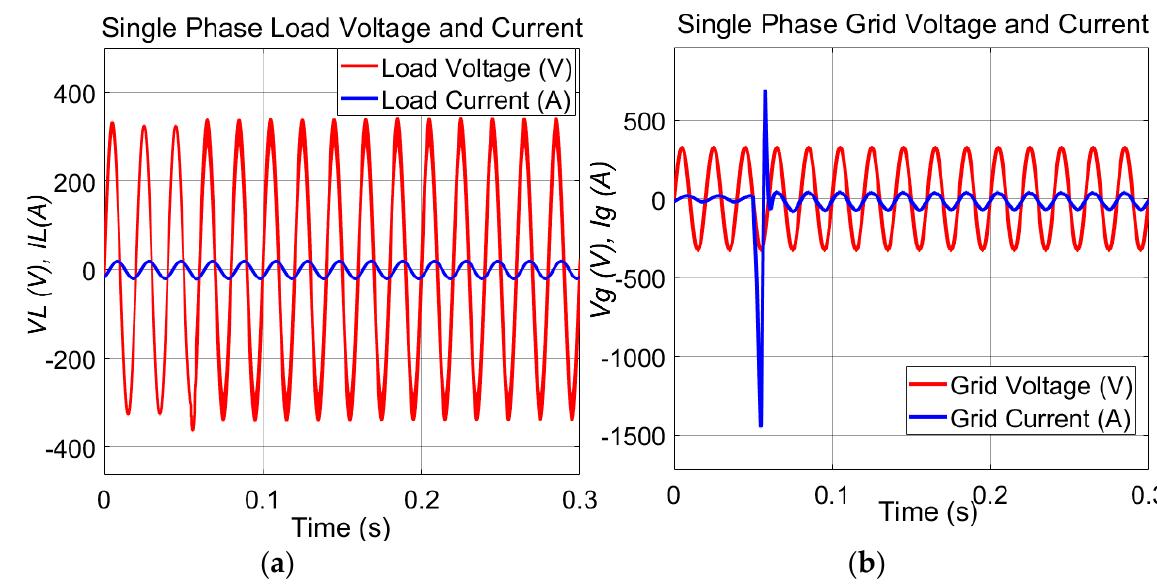
Figure 14. ( a ) single phase load voltage and current. ( b ) Grid voltage and current.